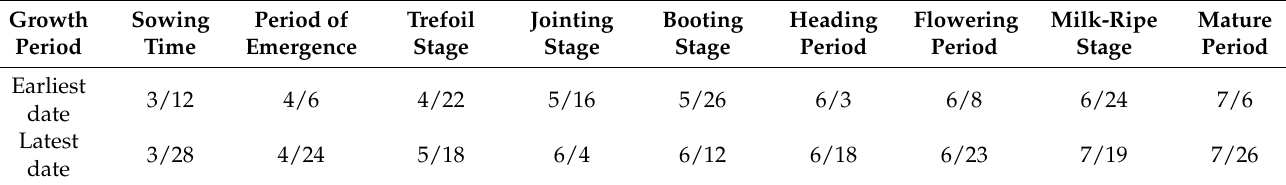
Table 3. Earliest and latest date of growth stage for spring wheat from 1987 to